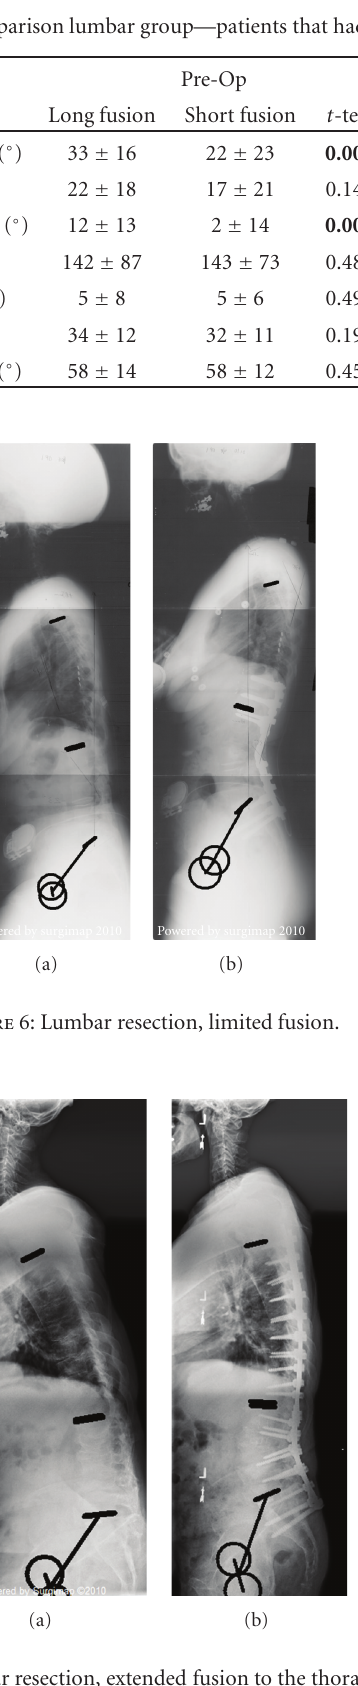
Figure 7: Lumbar resection, extended fusion to the thoracic